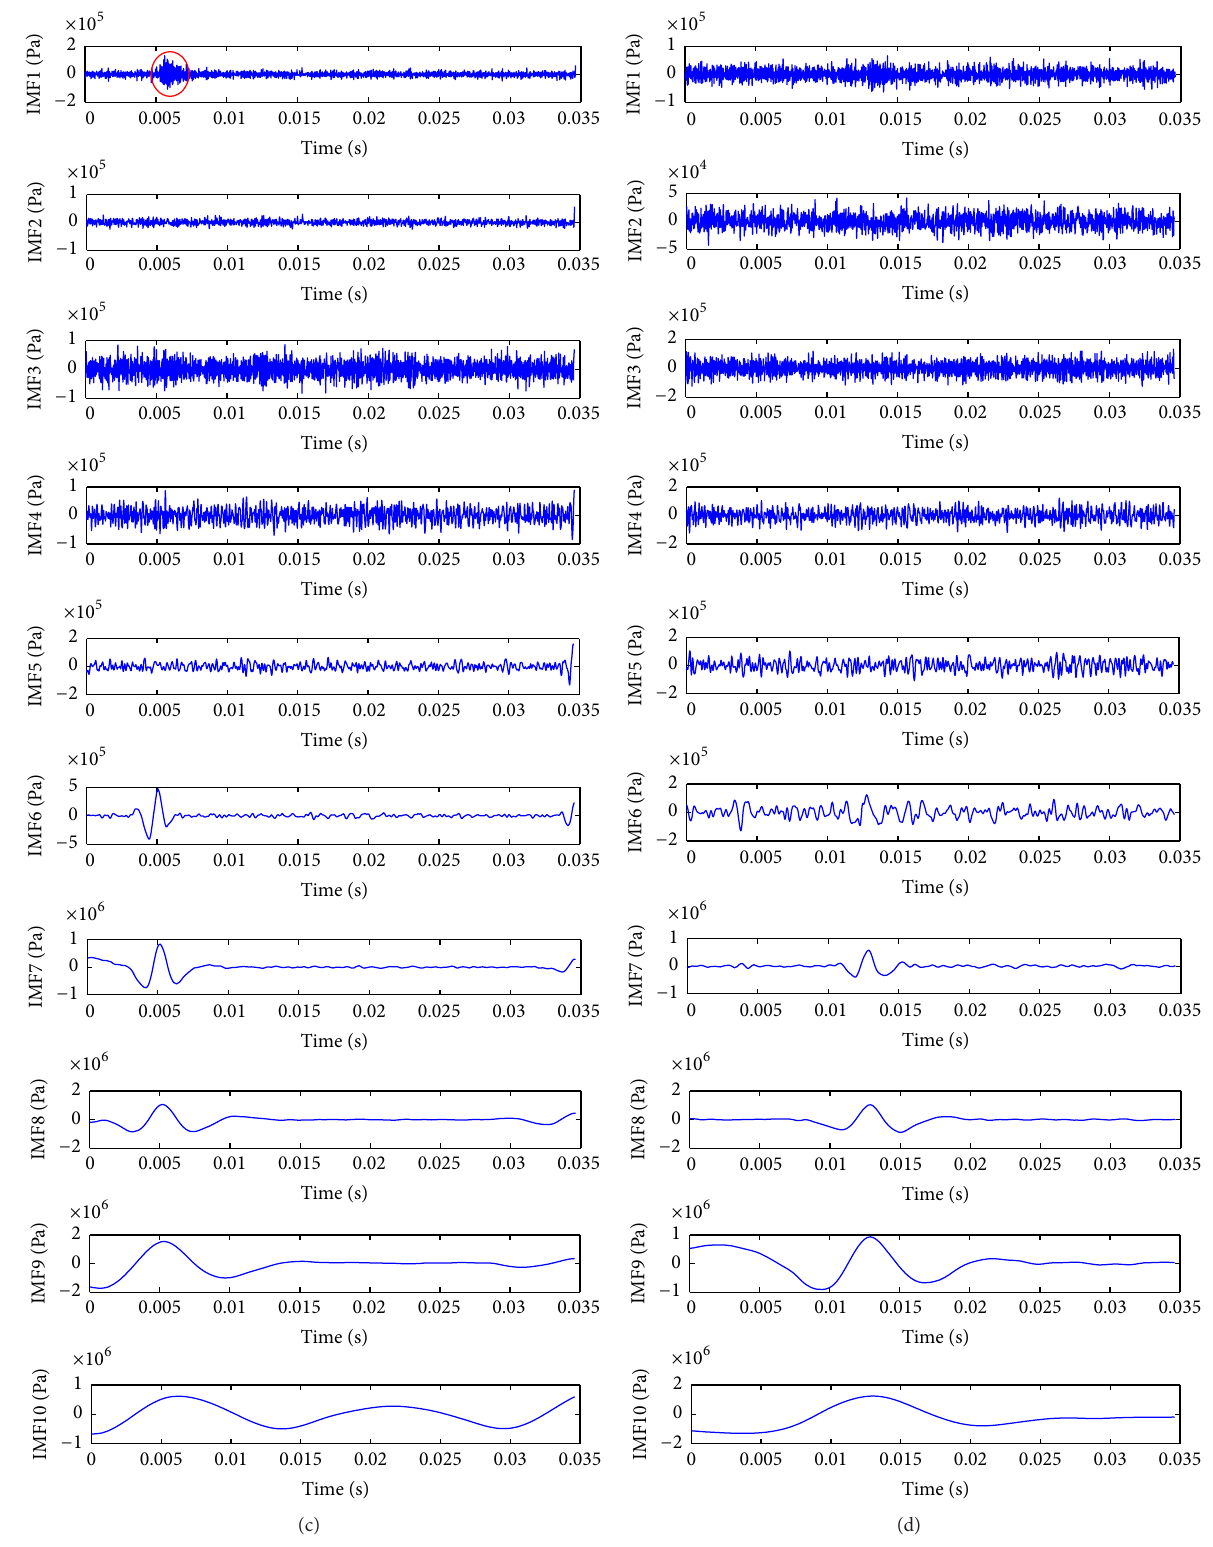
Figure 9: (a) Decomposition Results of CEEMD for cylinder pressure signal of cylinder 1. (b) Decomposition Results of CEEMD for cylinder pressure signal of cylinder 2. (c) Decomposition Results of CEEMD for cylinder pressure signal of cylinder 3. (d) Decomposition Results of CEEMD for cylinder pressure signal of cylinder